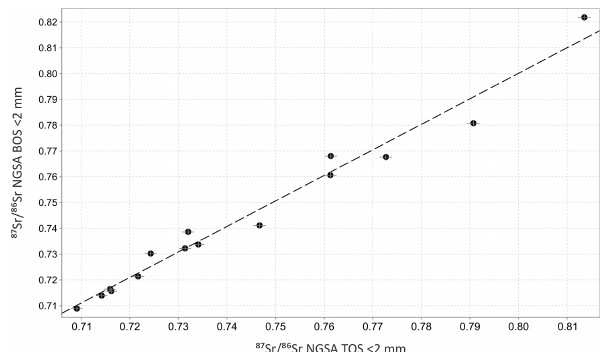
Figure 5. Scatterplot of the BOS (deep) versus TOS (surface) 87 Sr / 86 Sr data ( n = 15) from the northern Australia Sr isotope study area with total uncertainty derived from field duplicates (0.17%; grey plus symbols) and linear square regression line (dashed